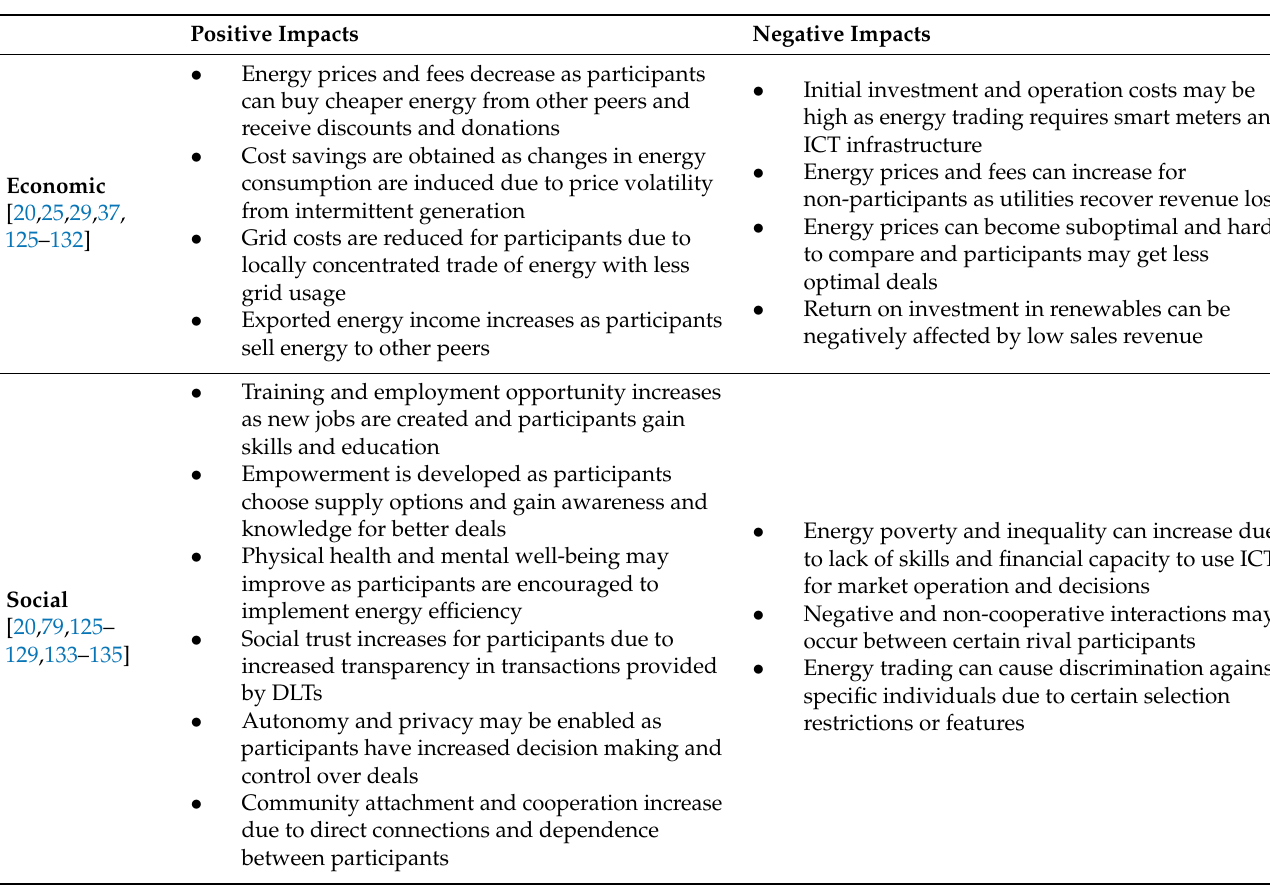
Table 5. Economic, social, environmental, technical, and legal impacts of LEMs for P2P energy